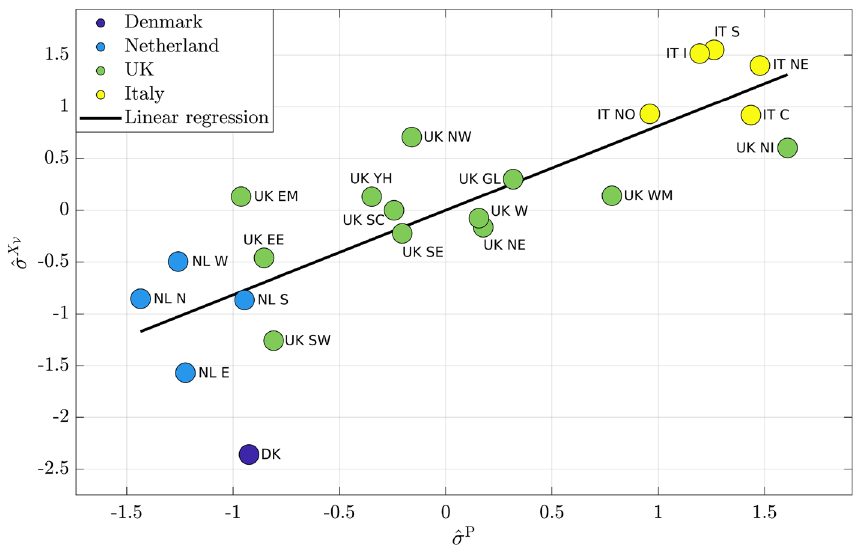
Figure 3. Comparison of standardized dataset ˆ σ P with standardized simulation ˆ σ X V .